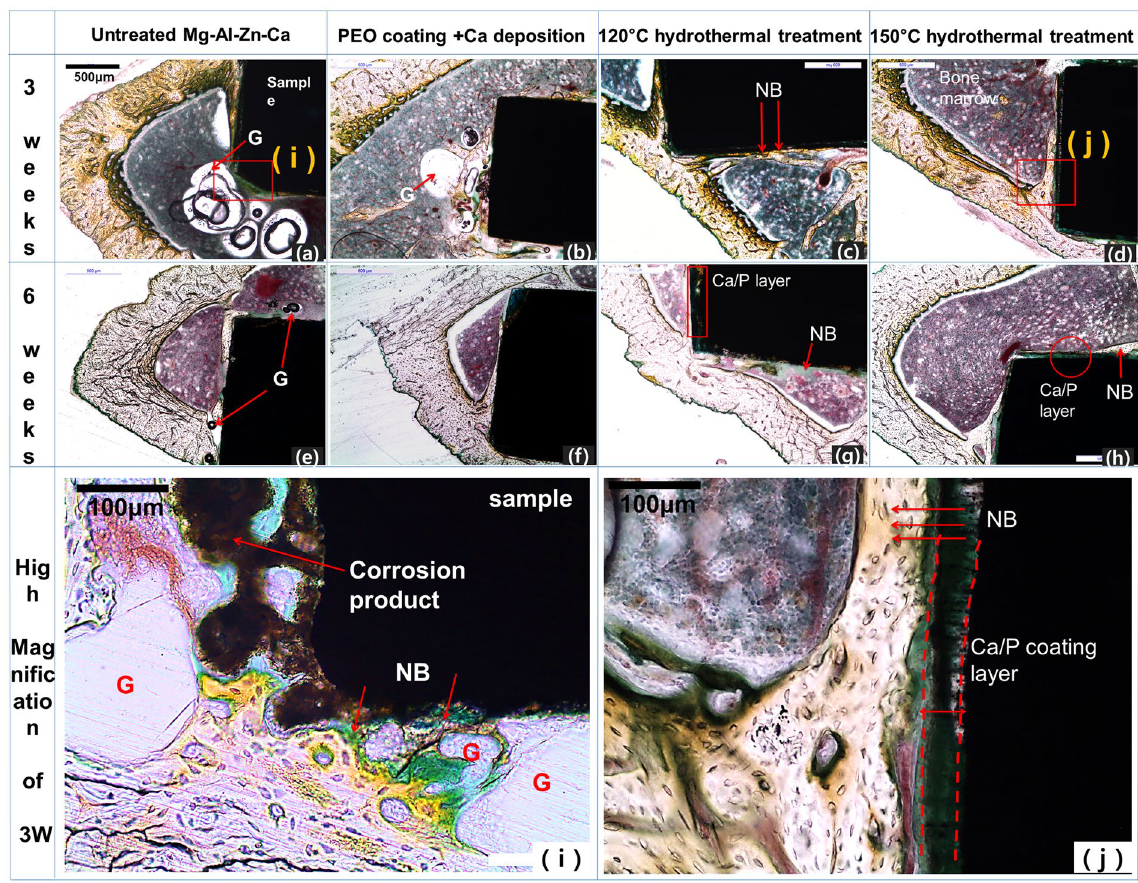
Figure 8. Histological analyses of rat tibia for each group 3 and 6 week after implantation, and high- magnification images of (i) Mg-3Al-1Zn-1.5Ca alloy and (j) after the hydrothermal treatment at 150 °C and implantation for 6